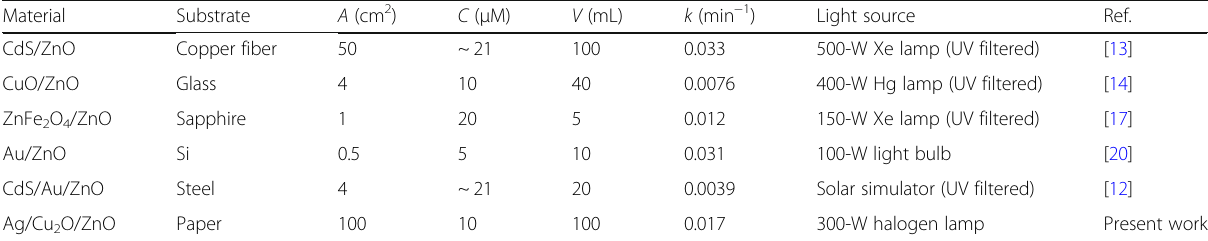
Table 1 A comparative table of photodegradation of RhB solutions